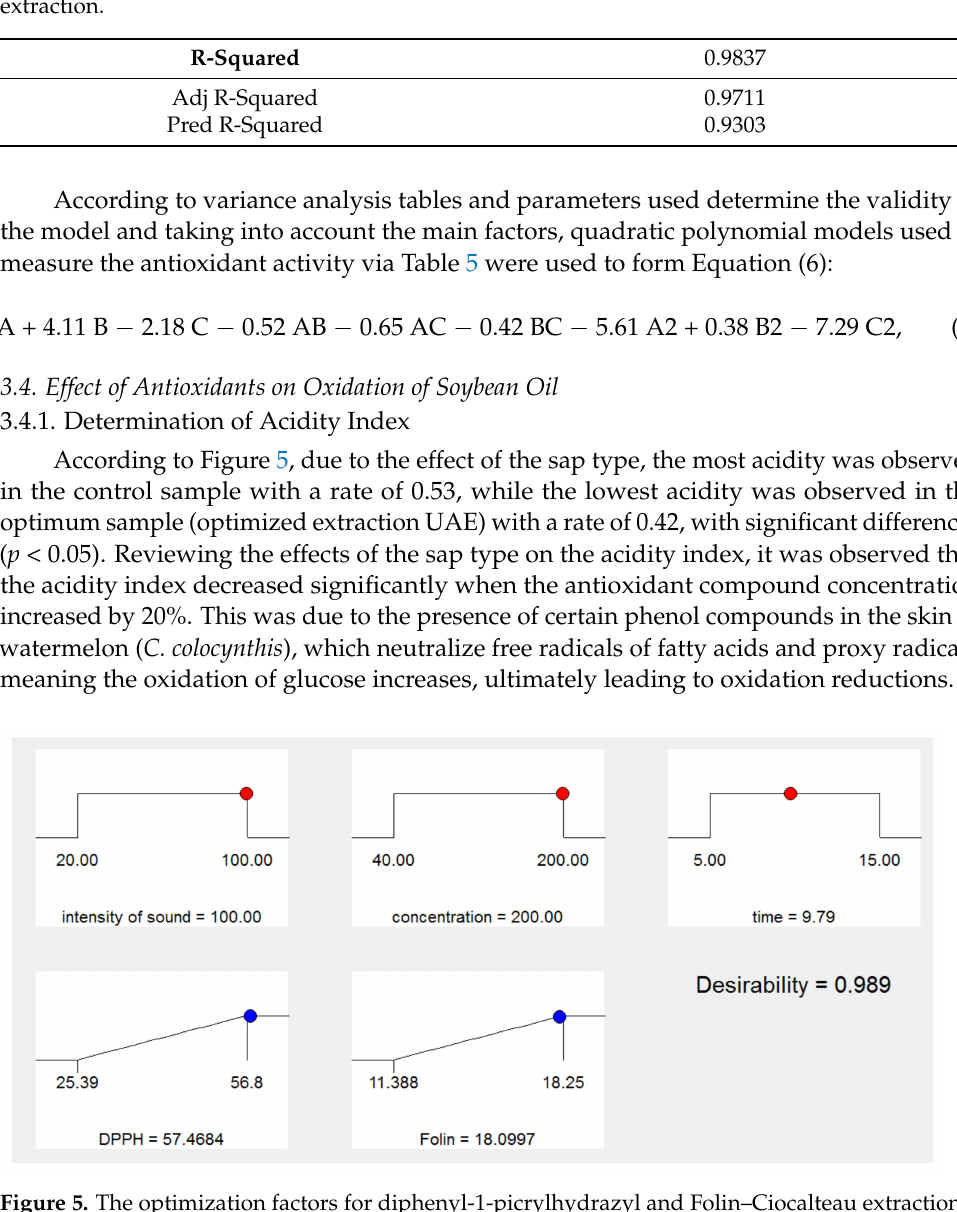
Figure 5. The optimization factors for diphenyl-1-picrylhydrazyl and Folin–Ciocalteau